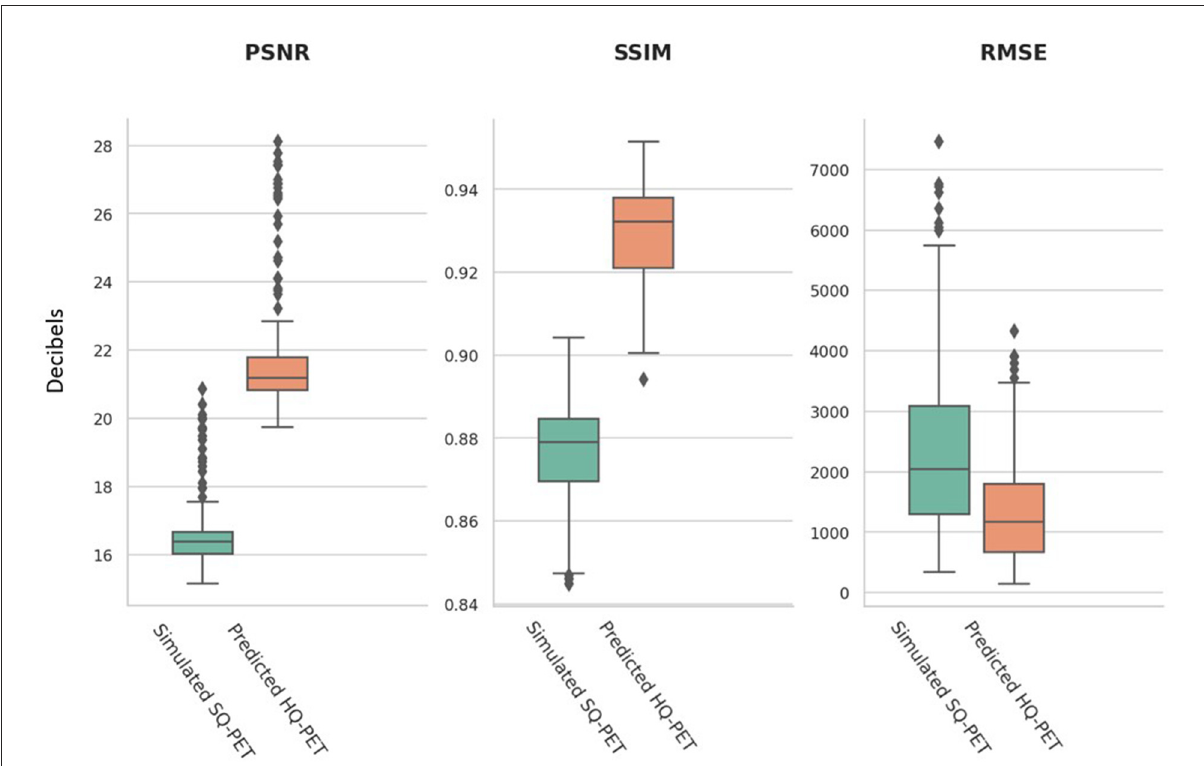
FIGURE3 Image quality metrics from the simulated standard-quality (SQ) PET and the predicted high-quality (HQ) PET for the test set. An objective improvement in image quality is reflected by larger values in peak signal to noise ratio (PSNR) and structural similarity index metrics (SSIM) and smaller values for the root mean square error